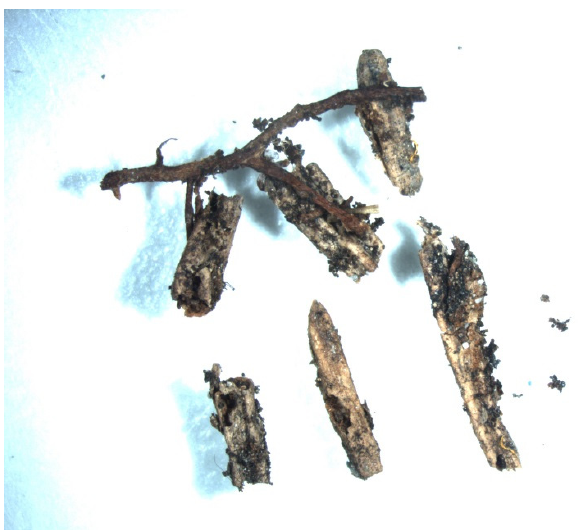
Figure 12. Recognizable needle fragments in the Oa layer. A fine root had penetrated the three upper needles and only the resistable cuticula was left. The three lower fragments however, had to a large degree retained their three ‐ dimentional shape. Dark faecal pellets of microarthropods can be seen on and outside the needle remains, especially the lower right and the middle upper one.